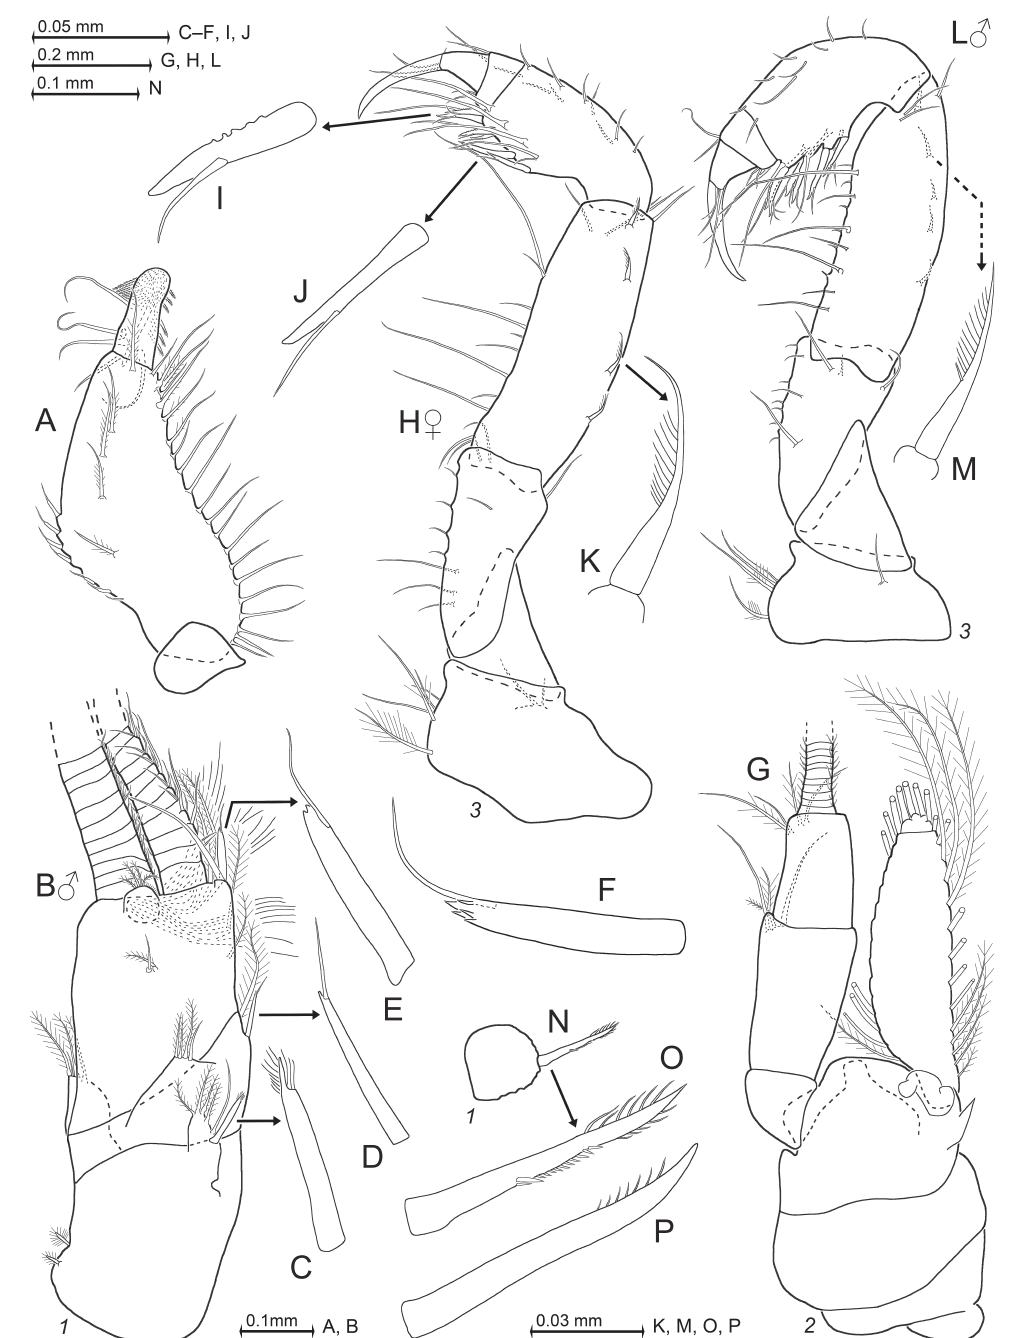
Fig. 5. Heteromysis hornimani sp. nov., paratypes from London, ♀ with body length 5.2 mm (A, H–K, P: NHMW 26975 ), ♂ 4.7 mm (B–E, G, L–O: NHMW 26976 ), and non-type from Wroclaw, ♀ 6.5 mm (F: NHMW 26982). A . Palp of left mandible, caudal; most setae of terminal segment are below drawing plane. B . Male antennula, dorsal. C–E . Details of male antennula (B) showing modified seta (C) and spines (D, E). F . Non-type variant of flagellate spine of terminal segment of antennula. G . Antenna with antennal gland, ventral. H . Right female thoracic sympod and endopod 3, rostral. I–K . Details of female endopod 3 (H) showing modified spines (I–J) of carpus and modified seta (K) of merus. L . Left male thoracic sympod and endopod 3, caudal. M . Detail showing modified seta of merus of male endopod 3 (L). N . Dactylus 1, setae omitted. O–P . Claw variants of dactylus 1